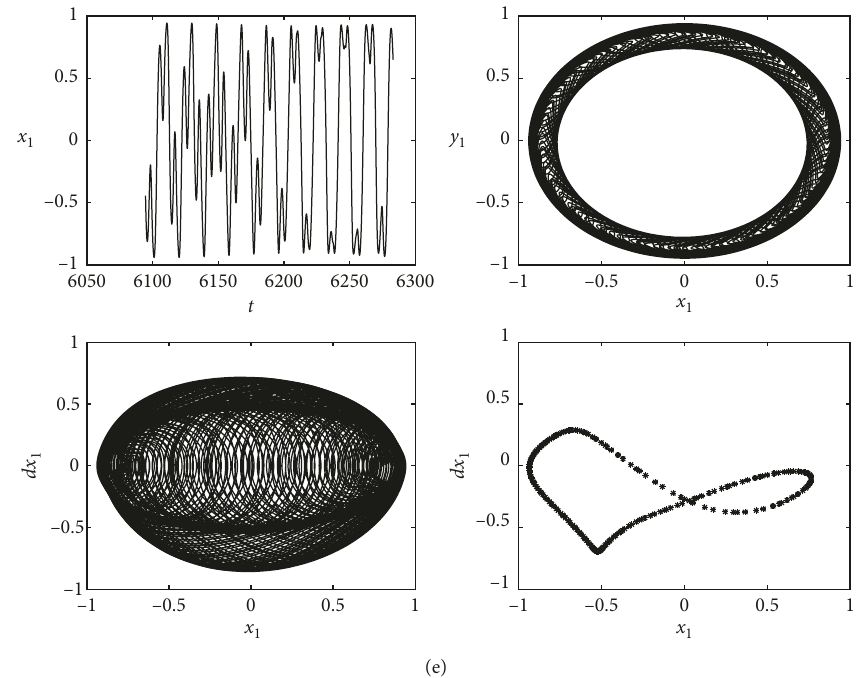
Figure 14: Response oftherotor systemat differentrotation speedswhen k (d) ω � 1875rad/s, and (e) ω �